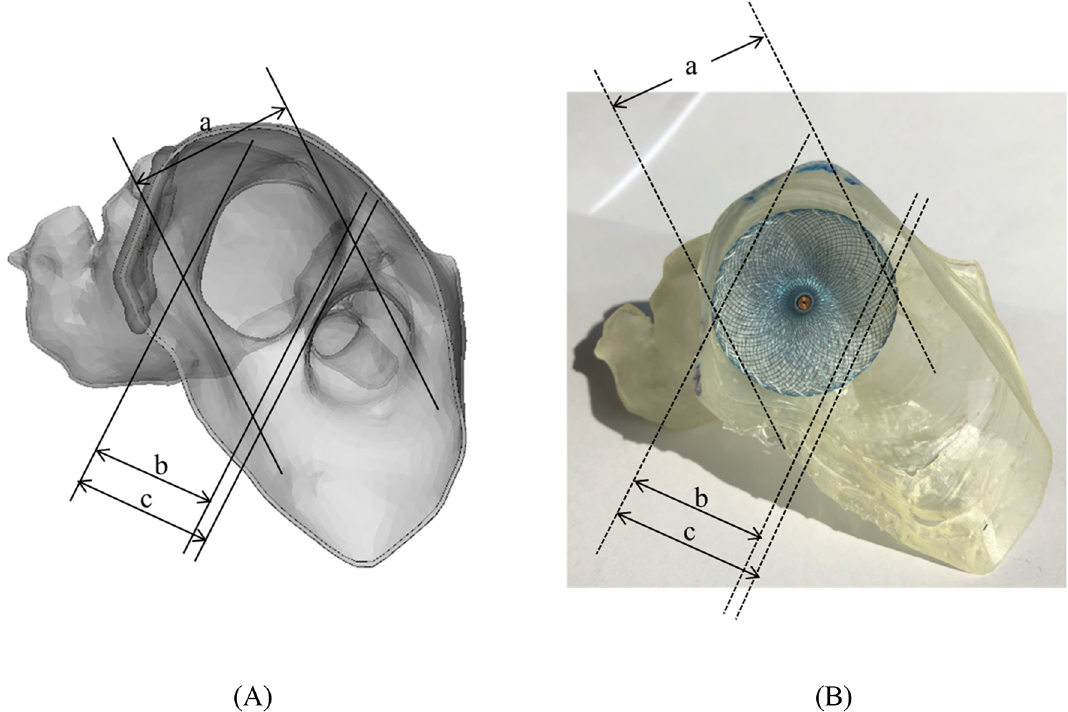
Figure 5. Measurements of shape accuracy between 3D model and 3D-printed phantom. ( A ) The 3D model (STL) with three landmarks specified for evaluating measurement error. ( B ) The 3D-printed phantom with three landmarks specified for evaluating measurement error. ( a , diameter of the horizontal zone; b , LAA ostium; c , vertical zone). 3D three-dimensional, LAA left atrial appendage, STL